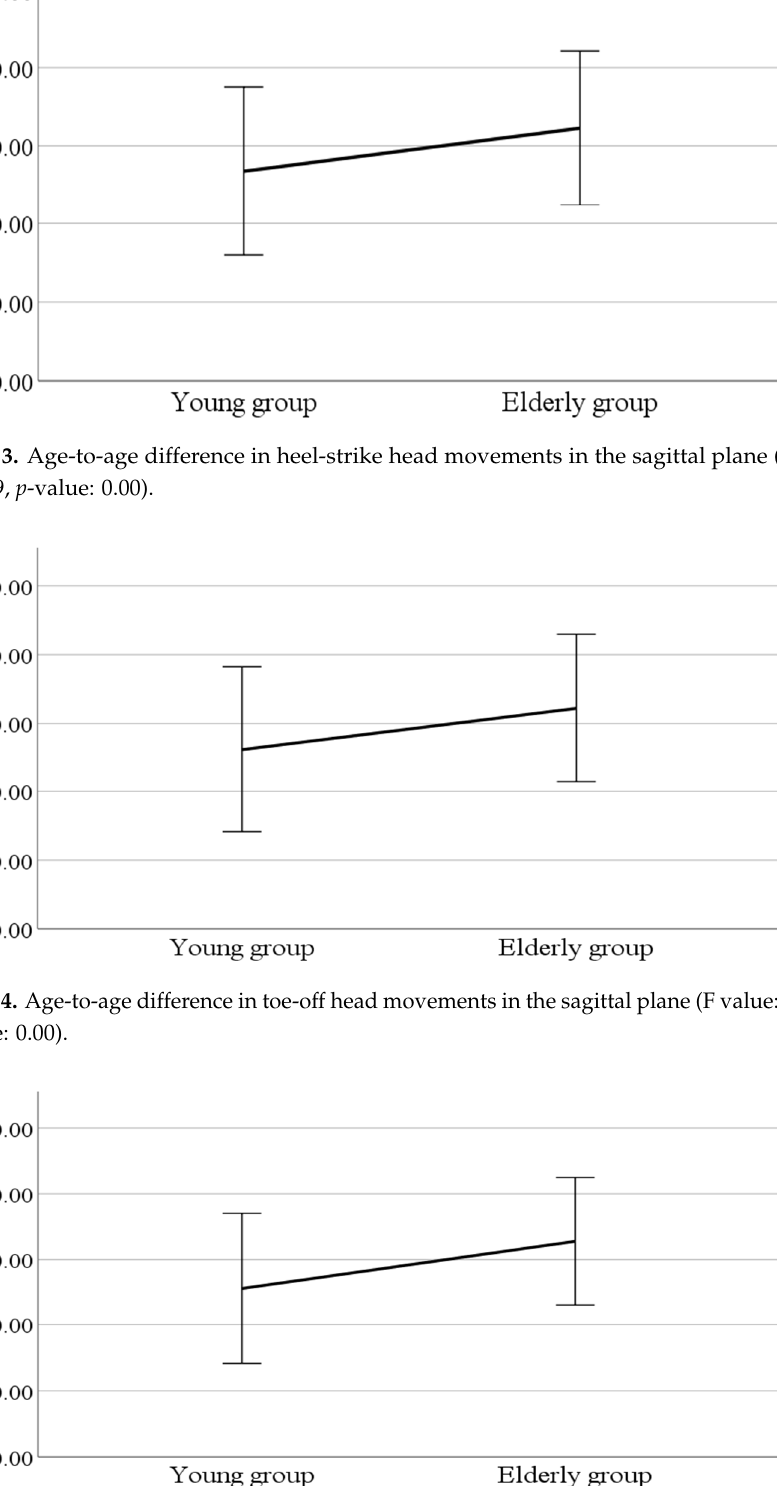
Figure 5. Age-to-age difference in mean head movements in the sagittal plane (F value: 2.88, DF: 289, p -value: